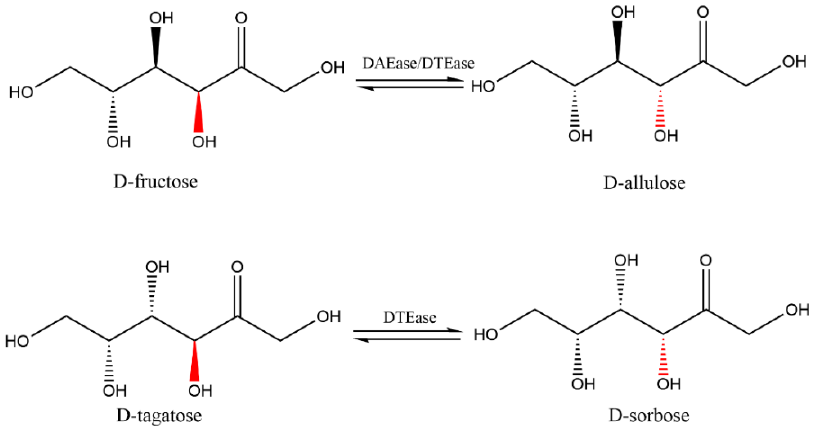
Figure 3. The epimerization reactions of substrates D -fructose and D -tagatose catalyzed by the DAE- ase/DTEase